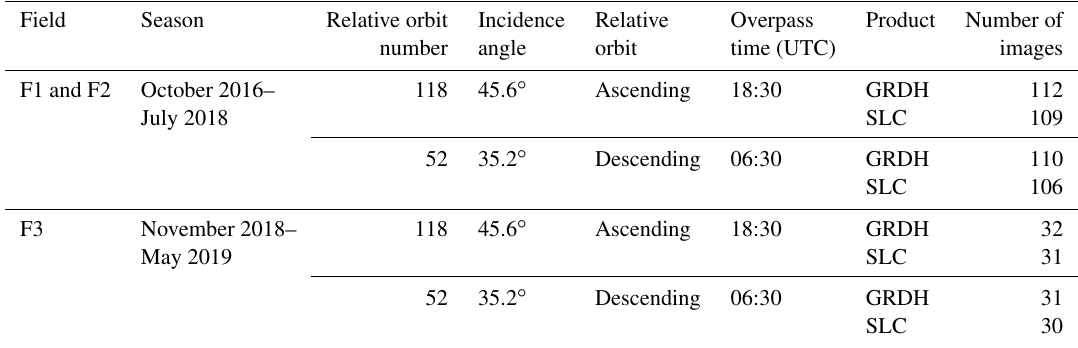
Table 3. Characteristics of the sentinel-1 products processed over the three fields for the monitored periods.